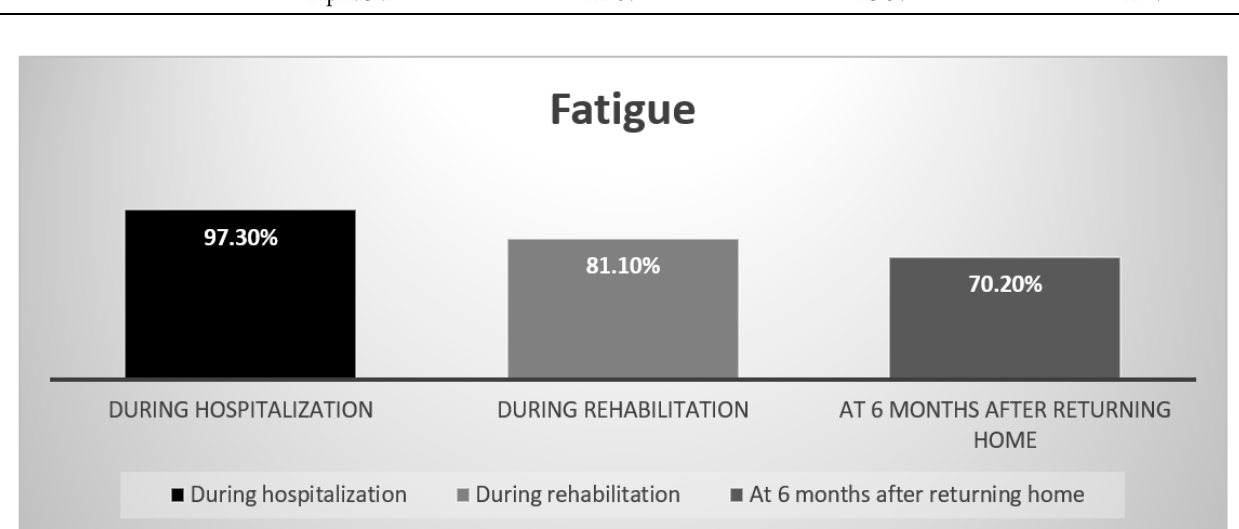
Figure 5. Fatigue persistence.